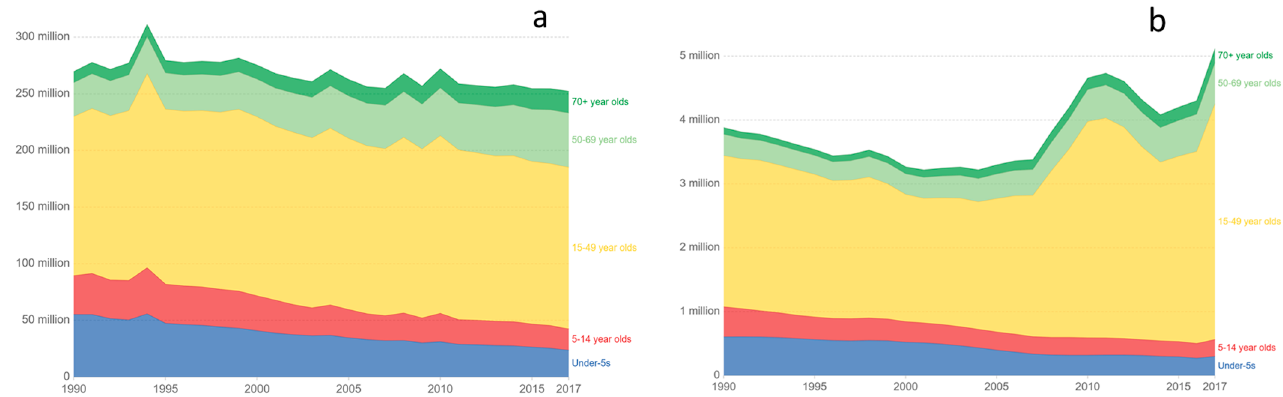
Figure A2. Burden of disease from injuries by age from 1990 to 2017 ( a ) Data for the worldwide population. ( b ) Data for the Mexican population. Disease burden is measured in disability-adjusted life years (DALYs). DALYs are used to measure the total impact of disease, both from years of life lost and years lived with a disability. One DALY equals one lost year of healthy life. Information provided by Institute for Health Metrics and Evaluation [45].